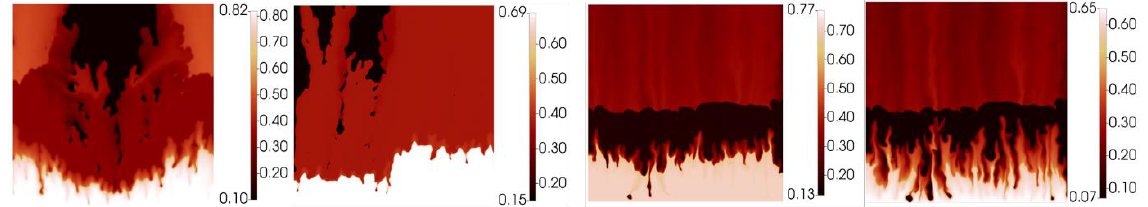
Figure 18. Finger patterns for displacement of 412 mPa.s, 616 mPa.s, 2000 mPa.s and 7000 mPa.s oil ( left to right ) at 0.15 PV of polymer viscosified brine injected.